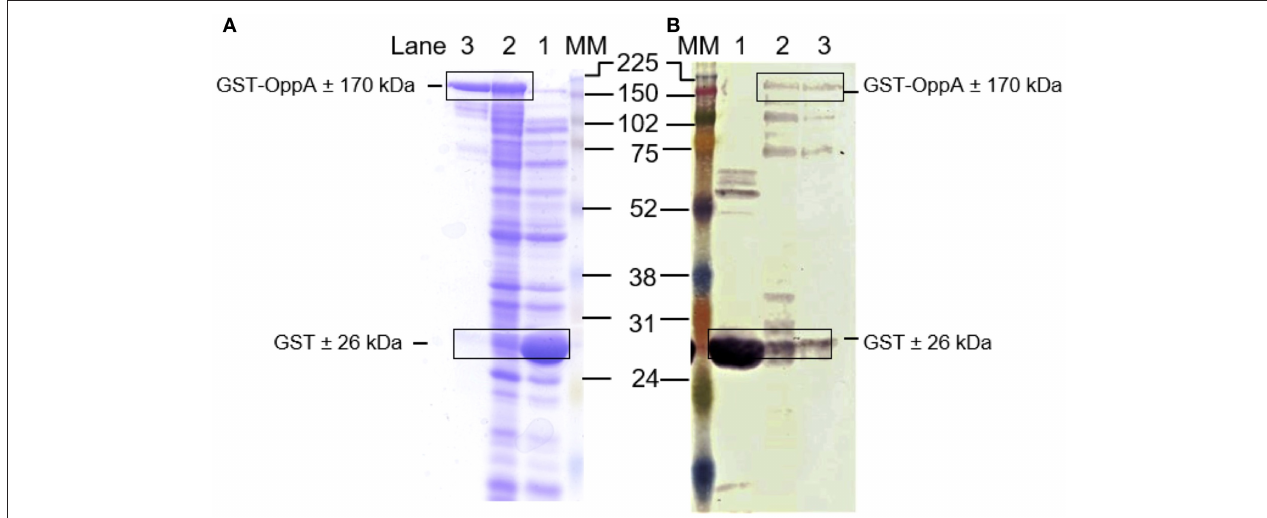
FIGURE 1 | Expression of recombinant GST-OppA protein. (A) SDS-PAGE analysis of the expressed OppA protein and (B) western blot analysis using anti-GST antibody. Lane 1 E. coli BL21(DE3)pLysS cells expressing GST-control, lane 2 E. coli BL21(DE3)pLysS cells expressing GST-OppA protein, and lane 3 isolated recombinant GST-OppA protein. MM is the GE Healthcare full-range rainbow molecular weight marker, molecular sizes indicated in kDa.